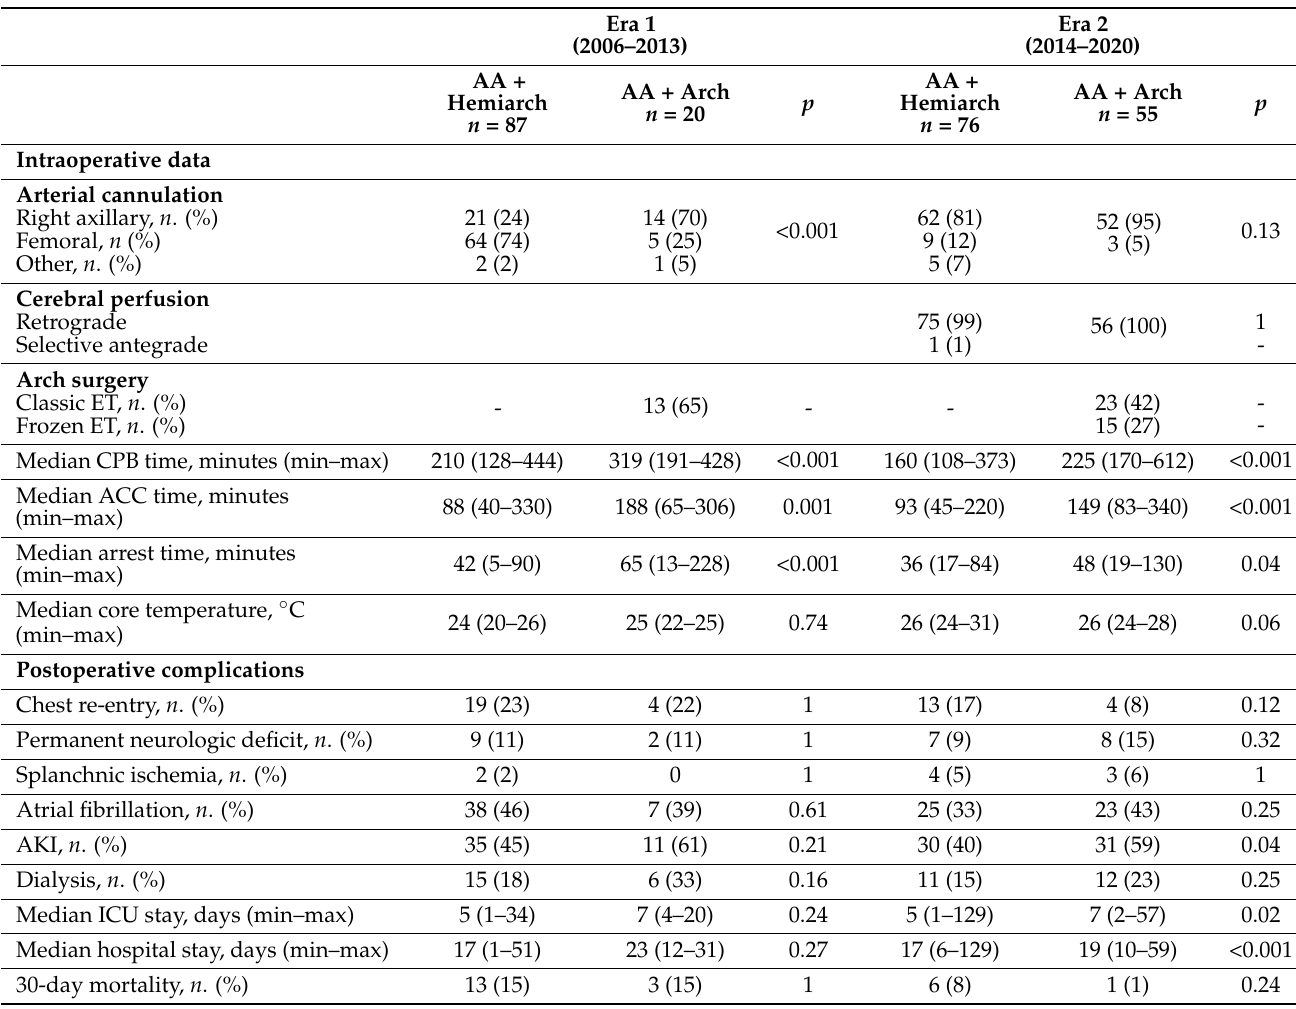
Table 3. Summary of operative data according to the surgical